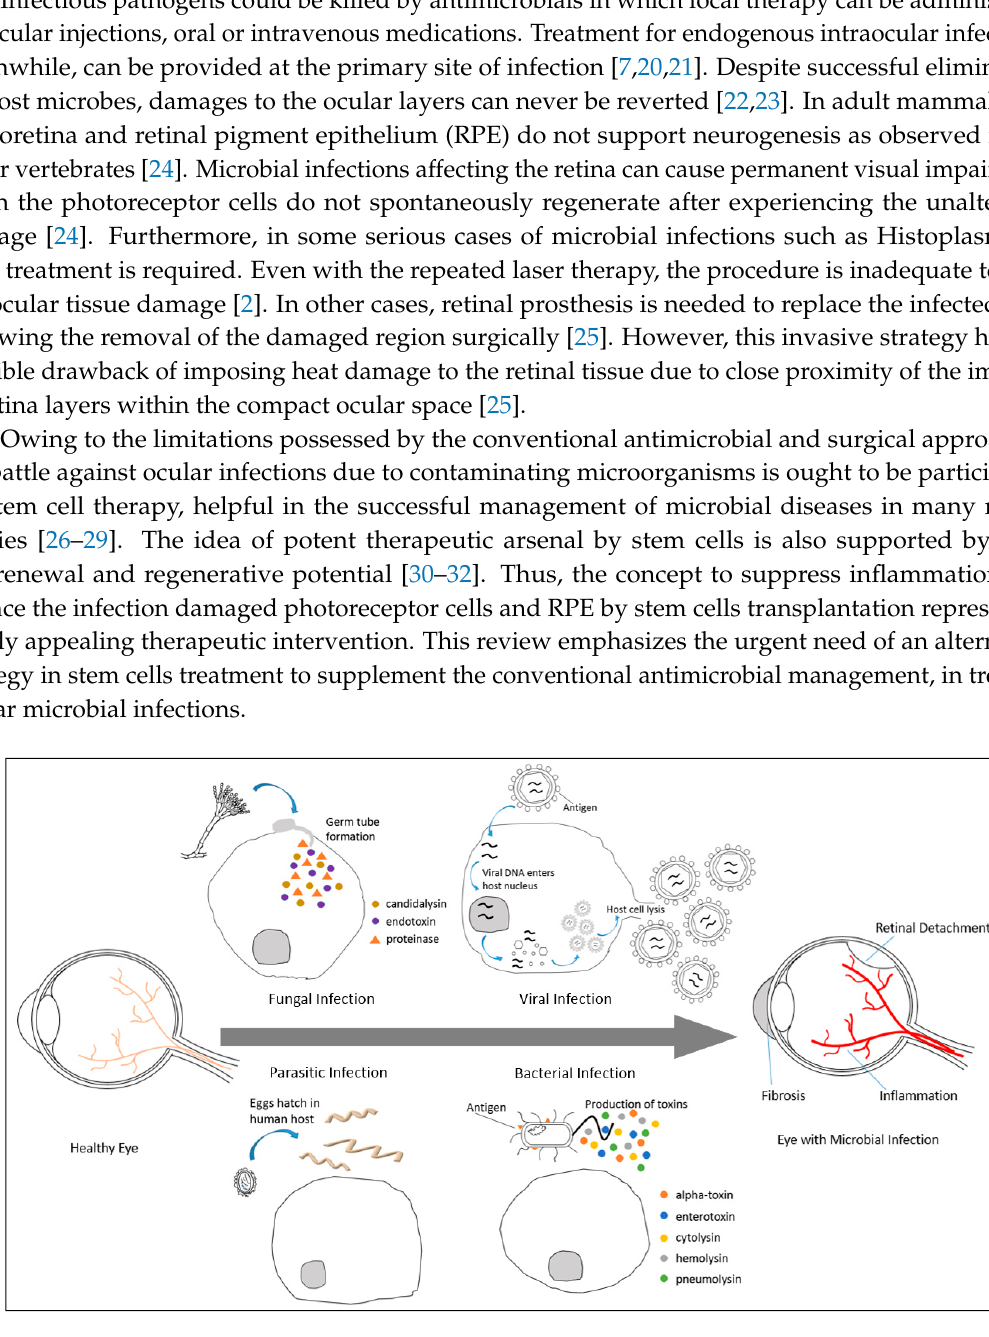
Figure 1. Molecular pathogenesis of ocular microbial infections. The infectious microorganisms can cause inflammation, retinal detachment and tissue fibrosis in affected eyes. Fungus attacks host cells